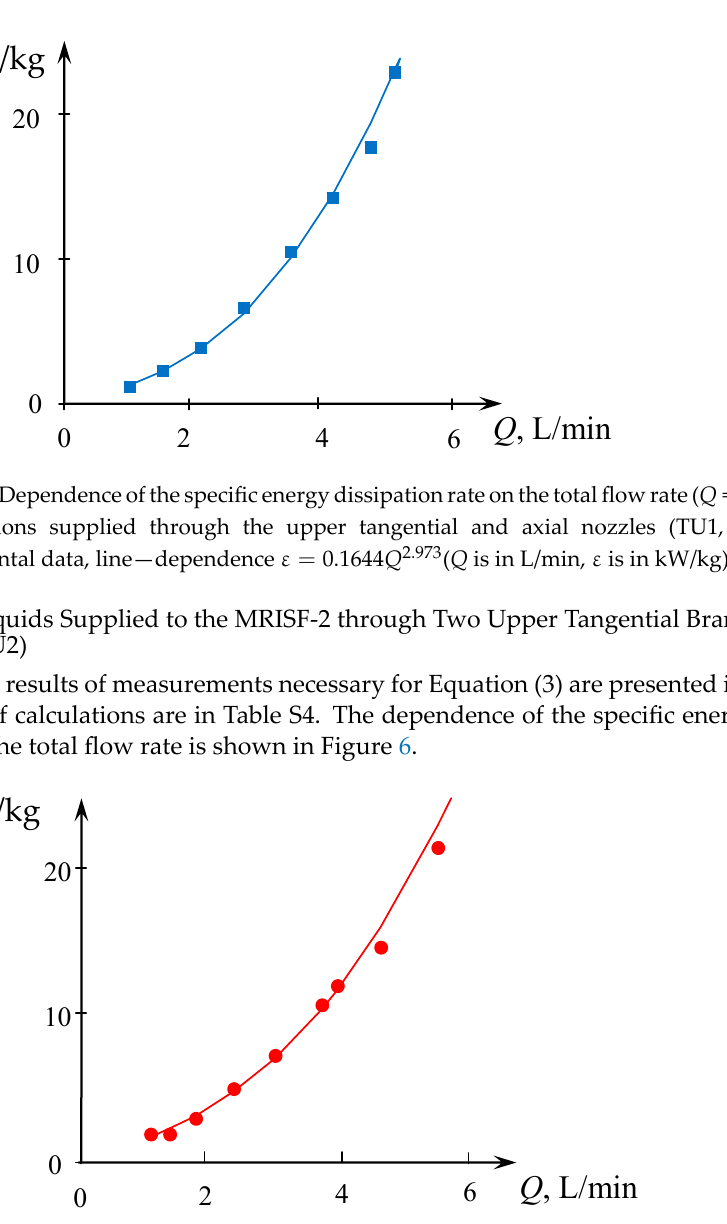
Figure 6. Dependence of the specific energy dissipation rate on the total flow rate ( Q = Q 2 = Q 1 a + Q 1 b ) for solutions supplied through two upper tangential branch pipes (TU1, TU2). Points—experimental data, line—dependence ε = 0.207 Q 2.732 ( Q is in L/min, ε is in kW/kg).